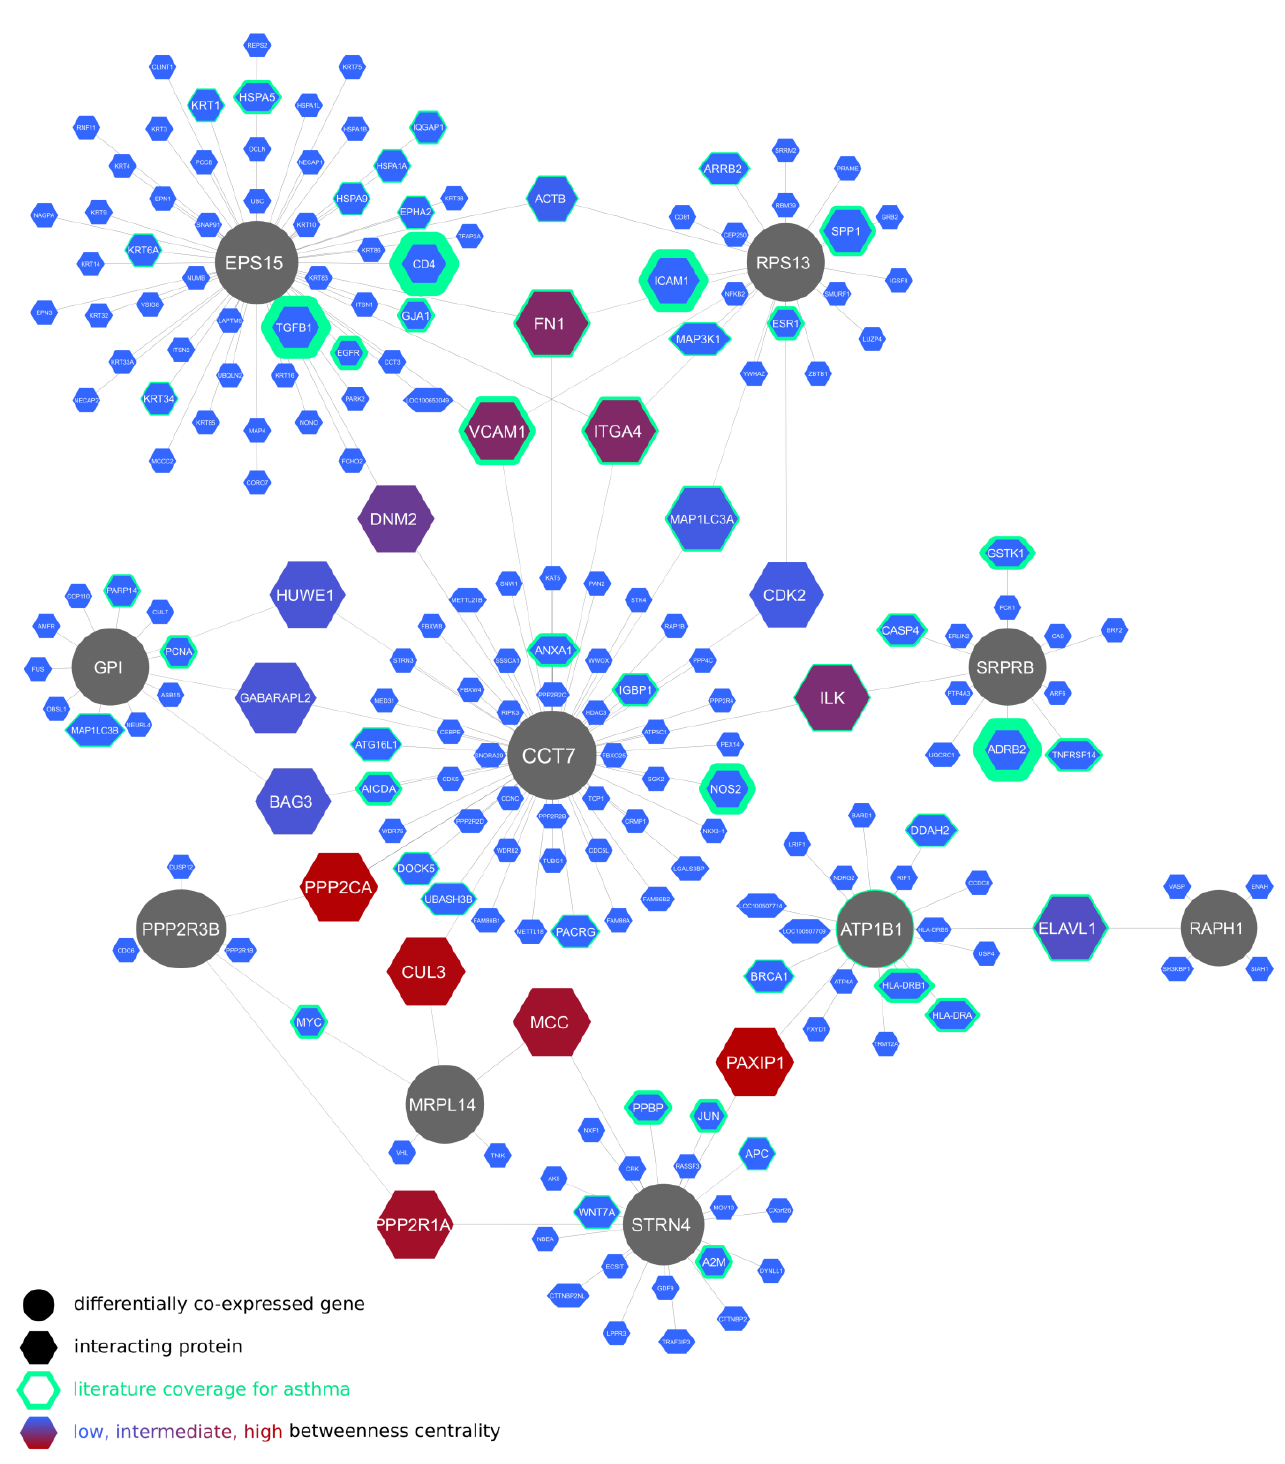
Figure 1. Lung-specific protein – protein interactions of genes differentially co-expressed between eosinophilic and non-eosinophilic asthma patients in bronchial brush biopsy samples.